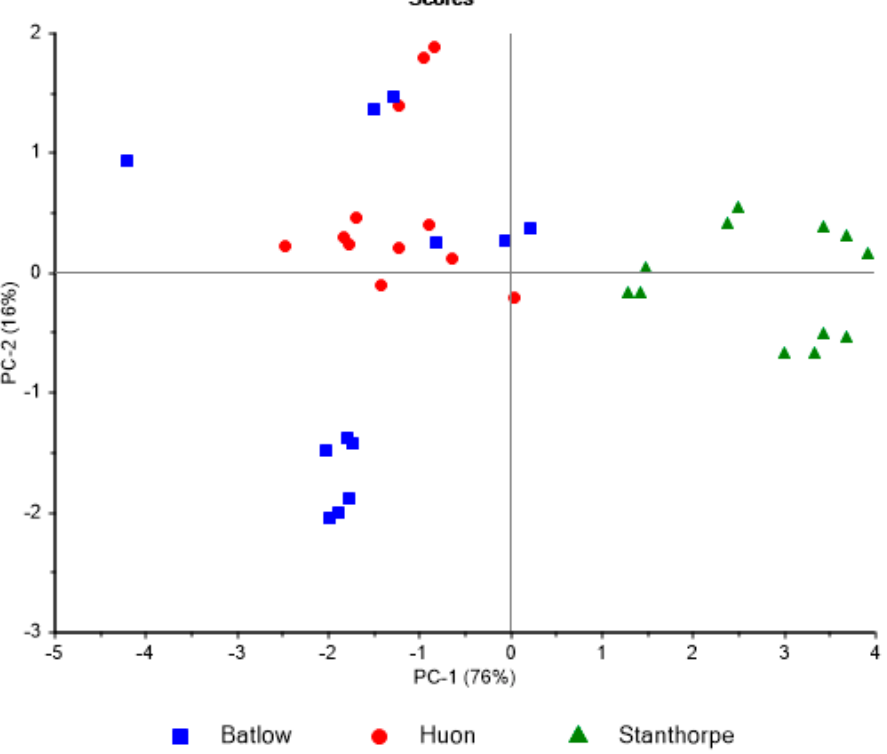
Figure 2. Scores plot for principal component analysis (PCA) for all four base chemical parameters of ciders made using “Fuji” apples from Huon Valley, Batlow and Stanthorpe ( n = 12 per region, per